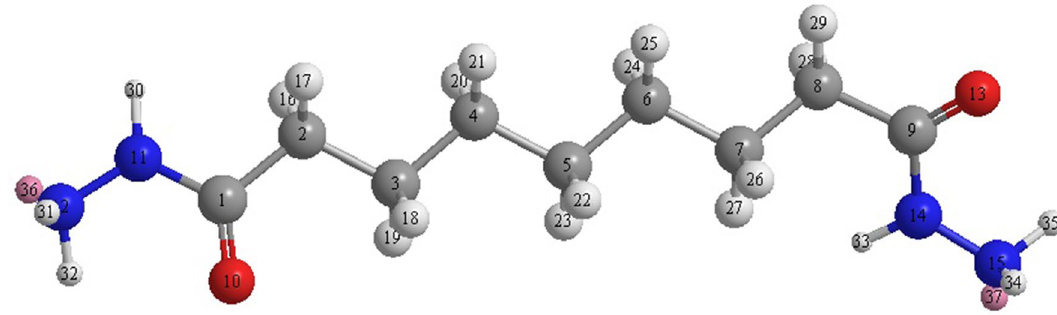
Figure 17. Fukui functions of the studied